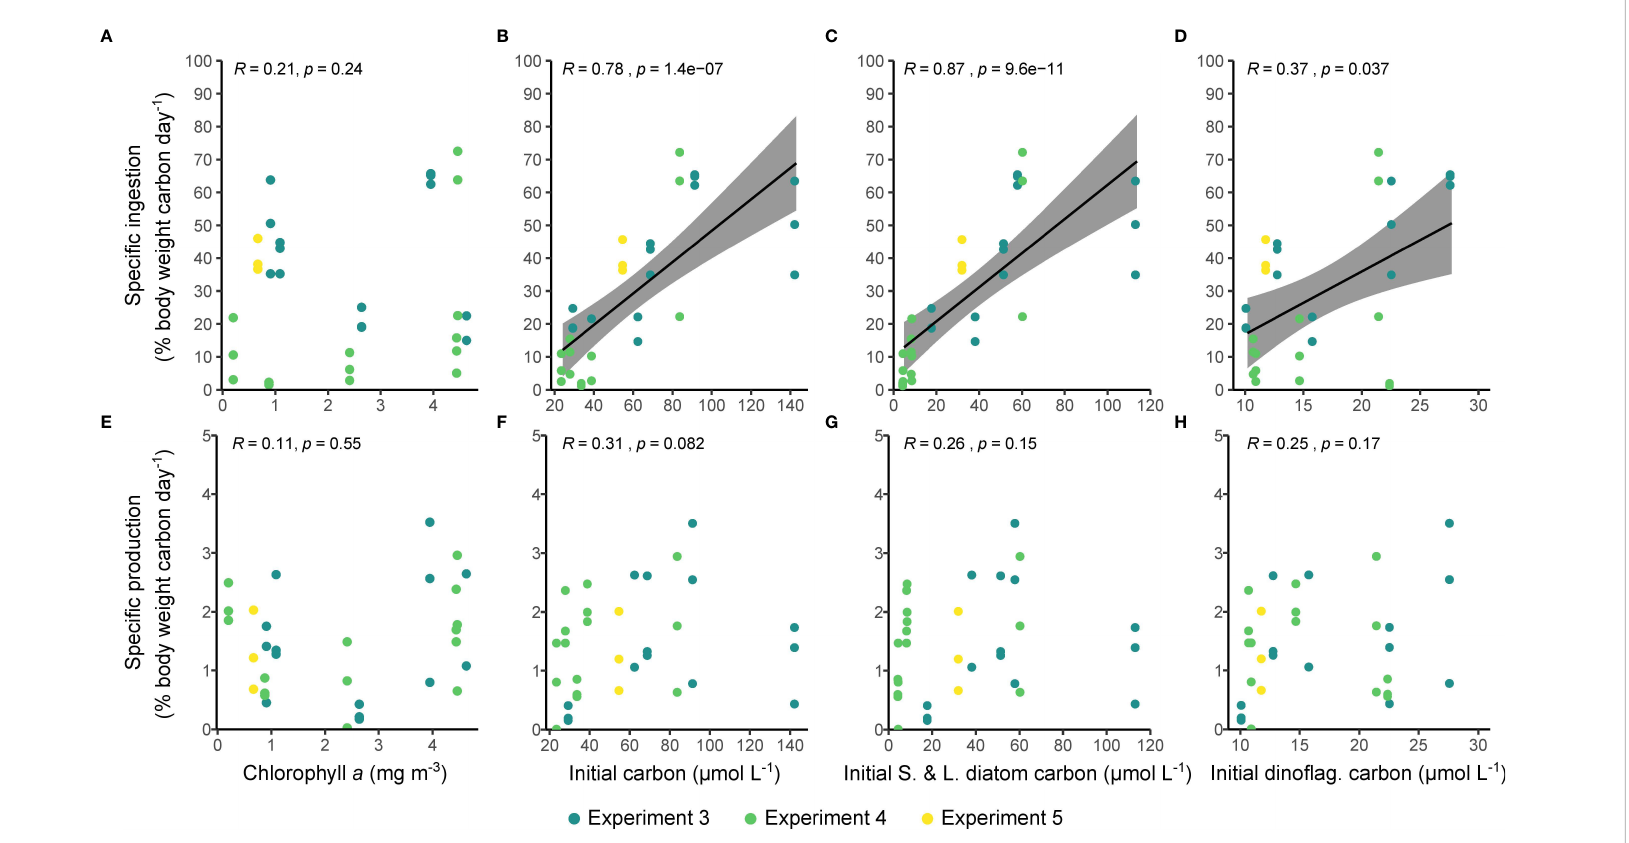
FIGURE 6 The relationships between the quantity of available food and ingestion (A – D) and egg production rate (E – H) . The quantity of available food is estimated from using the chlorophyll a concentration as a proxy (A, E) , and calculated using inverted microscopy for all cell types (B, F) , for small (S) and large (L) diatoms (C, G) , and for dino fl agellates (D, H) . Shaded areas show 95% con fi dence intervals. R is Spearman ’ s